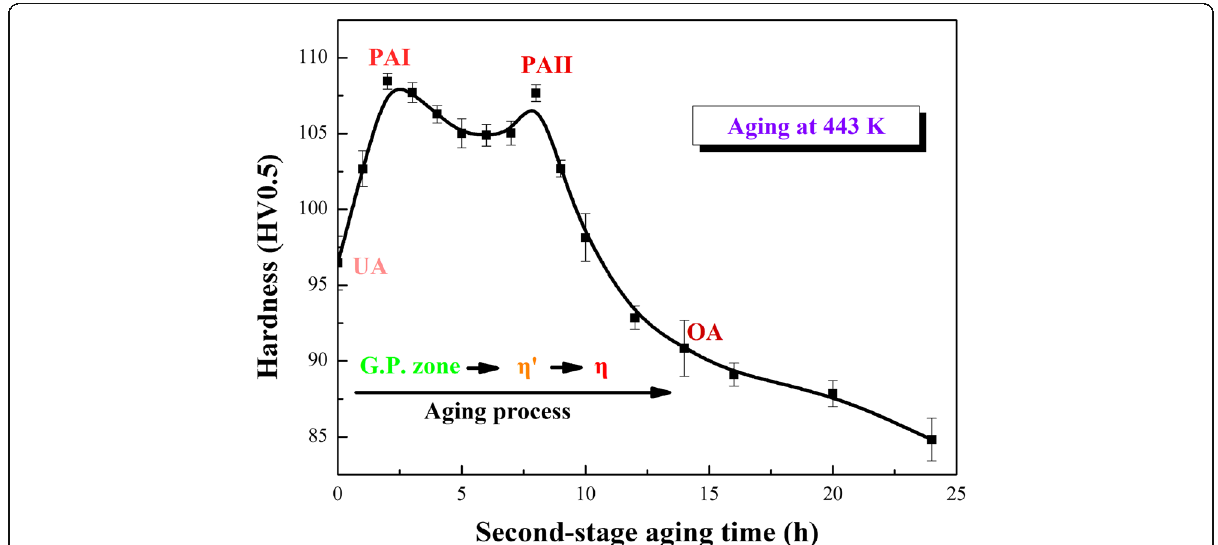
Fig. 1 Aging-hardening curve of the experimental alloy in the second-stage aging